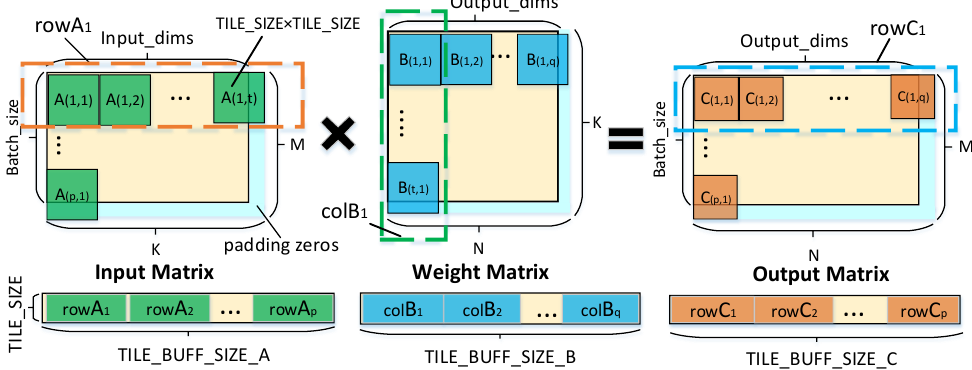
Figure 3. Matrix partitioning and